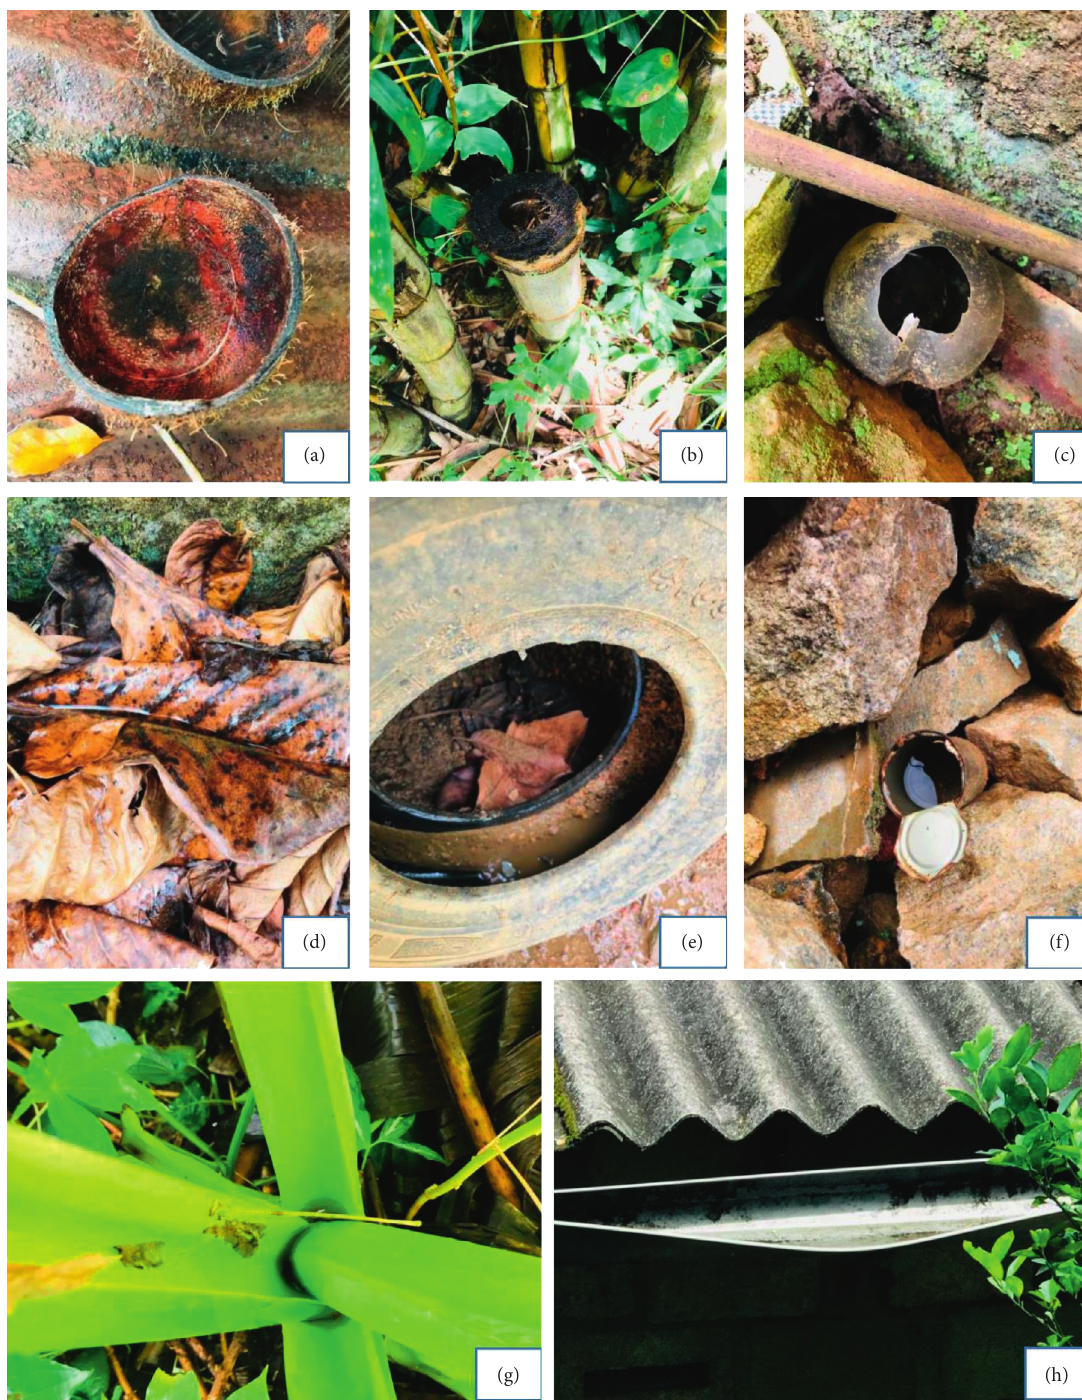
Figure 3: Immature mosquito habitats, (a) coconut shell, (b) bamboo tree hole, (c) clay pot, (d) leaf litter, (e) tire, (f) metal container, (g) leaf axil, and (h) roof